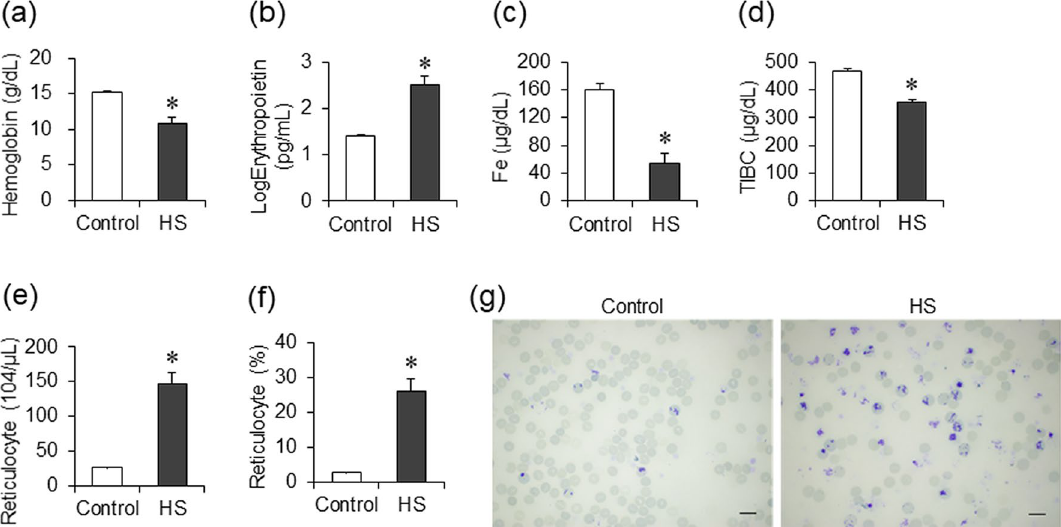
Figure 1. Characteristics of anemia in Dahl/SS rats. Comparison of hemoglobin ( a ), log-transformed serum erythropoietin ( b ), Fe ( c ), and total iron binding capacity (TIBC) ( d ) levels in the control (n = 7) and the HS (n = 8) groups at 15–17 weeks of age. The number ( e ) and ratio ( f ) of reticulocyte in the control (n = 7) and the HS (n = 9) groups. Supravital staining image of reticulocytes by new methylene blue (bars 10 μm) in the control and the HS groups ( g ). Statistical analysis was performed using unpaired Student’s t test by JMP Pro Version 14.2.0 software (SAS Institute Inc.). * p < 0.05 vs. the control